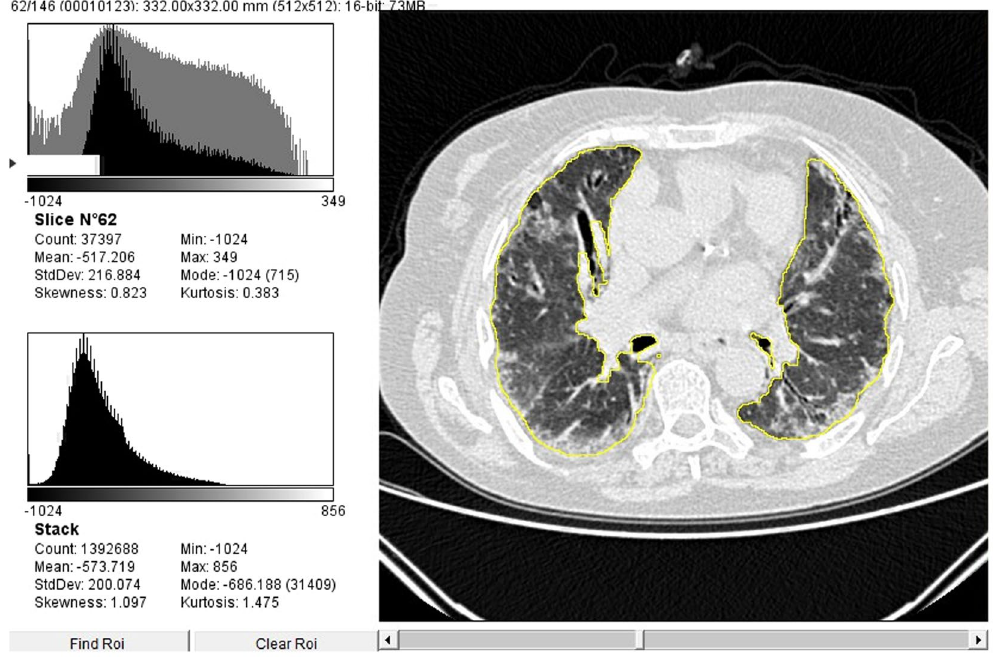
Figure 4. Comparison between quantitative and visual analysis of low-dose thin section volumetric lung CT in a SSc patient with ILD (Gho visual score > 20% 10 ; NSIP pattern) and a CII significantly lower than the cut-off value of 0.1966 (e. g. CII = − 2.7150). On the left, the figure shows the results from digital processing analysis: in the upper-left side of the image, data from the analysis of a single representative slice are given; in the lower-left side of the image the automatically generated averaged data from the analysis of all slices are given. Global pulmonary sampling has been performed and the sampled region is marked in yellow. CT = computed tomography; SSc = systemic sclerosis; ILD = interstitial lung disease; CII = computerized integrated index; NSIP = non-specific interstitial